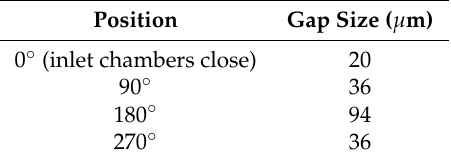
Table 1. Flank gap size evolution during the operation of the